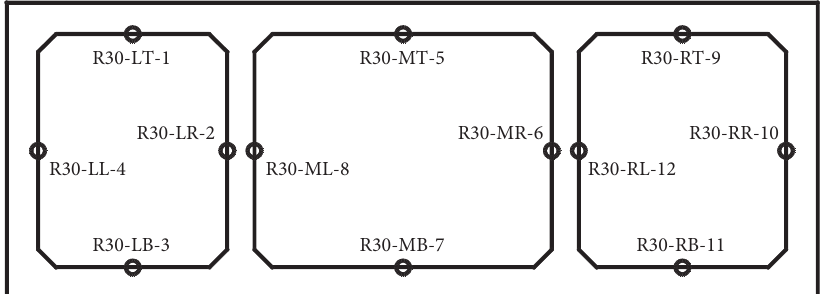
Figure 11: Monitoring points arrangement on cross section of the utility